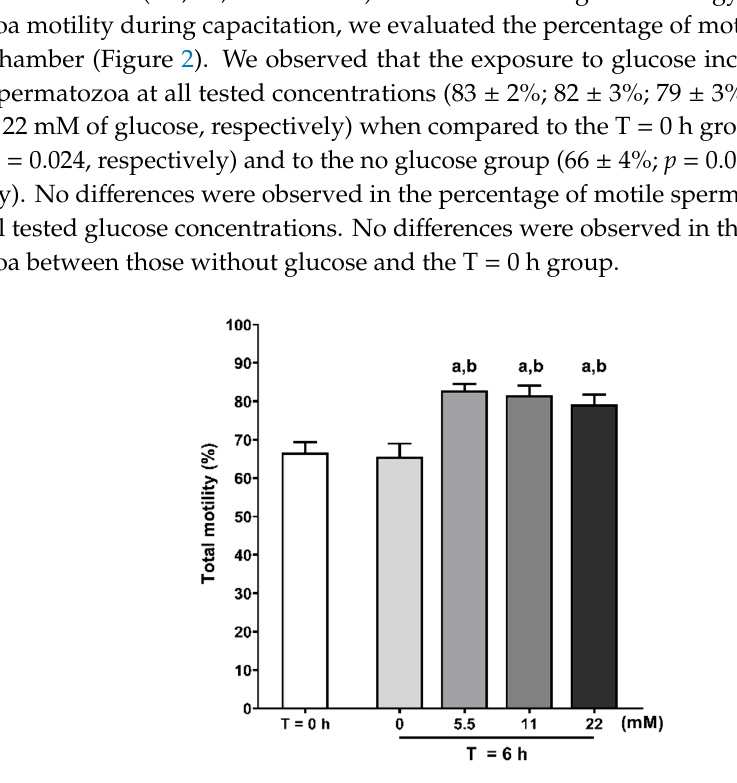
Figure 2. Evaluation of human spermatozoa total motility at baseline (T = 0 h) and without or with glucose (0, 5.5, 11 and 22 mM) stimuli following 6 h incubation in capacitation conditions. Results are expressed as mean ± SEM ( n = 20 for each condition). Significantly different results are expressed as: ( a ) Relative to T = 0 h group; ( b ) Relative to 0 mM glucose group (T = 6 h).